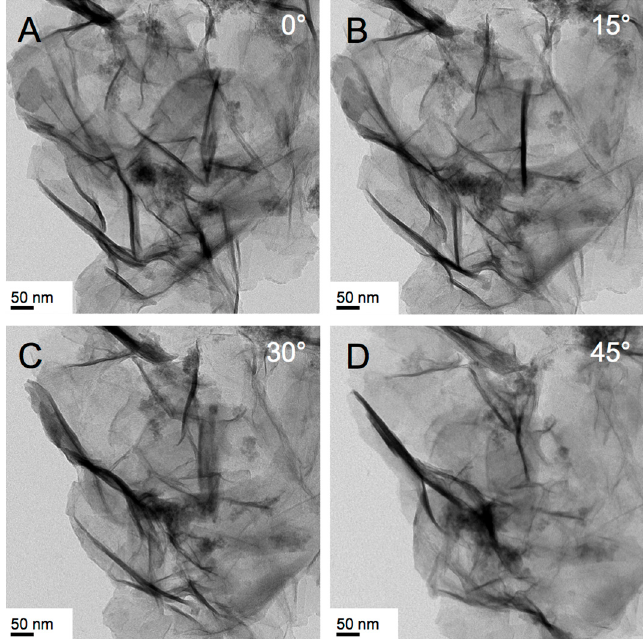
Figure 12. TEM tomography images (various degrees of tilt) of crumpled IO nanosheets obtained via the reduction/hydrolysis reaction of FeCl 3 in the isotropic micellar liquid (spherical micelles) formed by CTAB (3.6 wt %) in water at 50 °C (froth fraction).